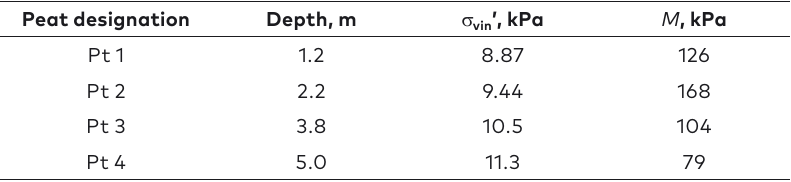
σ v ', Figure 5. The constrained modulus of peat in relation to effective stress